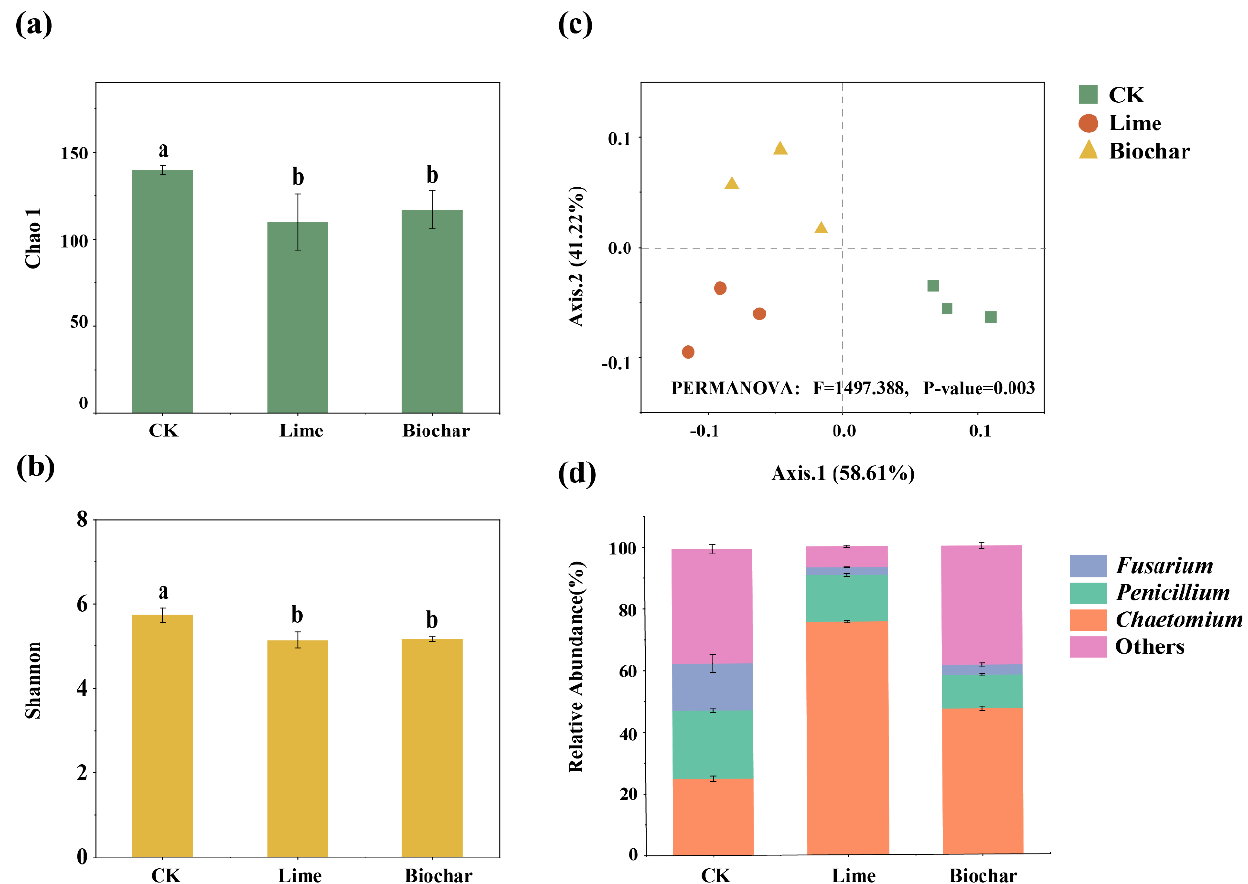
Figure 5. The alpha diversity of nirK − containing fungal denitrifiers including Chao 1 index ( a ) and Shannon index ( b ) on day 45. PCoA analysis of community structure based on Bray–Curtis matrix at OTU level ( c ). The relative abundance of nirK -containing fungal denitrifiers (%) at the genus level under different treatments ( d ). Error bars indicate standard deviations ( n = 3). Means followed by different letters indicate significant differences between treatments at p <